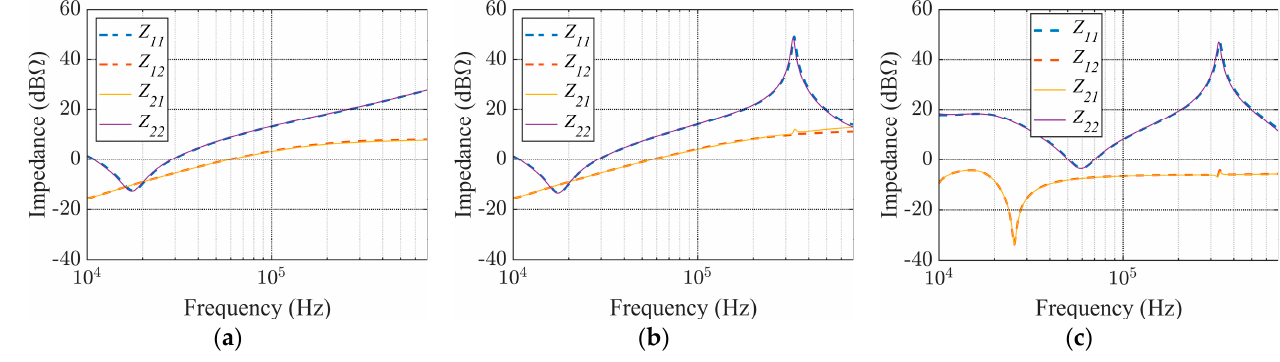
Figure 10. Impedance plots: ( a ) DOG-160G LISN (LISN A), ( b ) LISN B1, and ( c ) LISN B2.